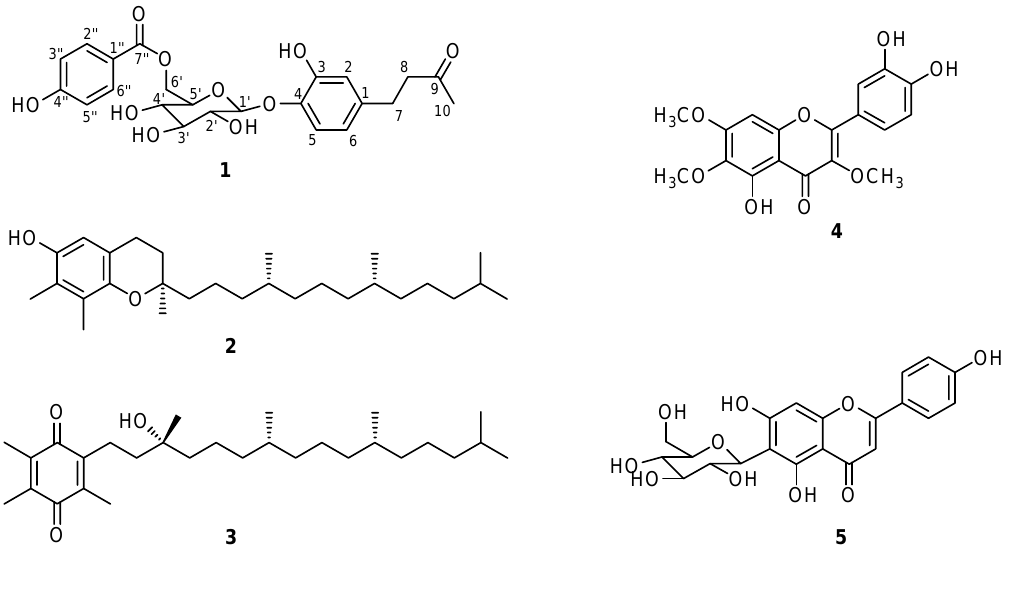
Figure 2. Structures of Compounds 1 - 5